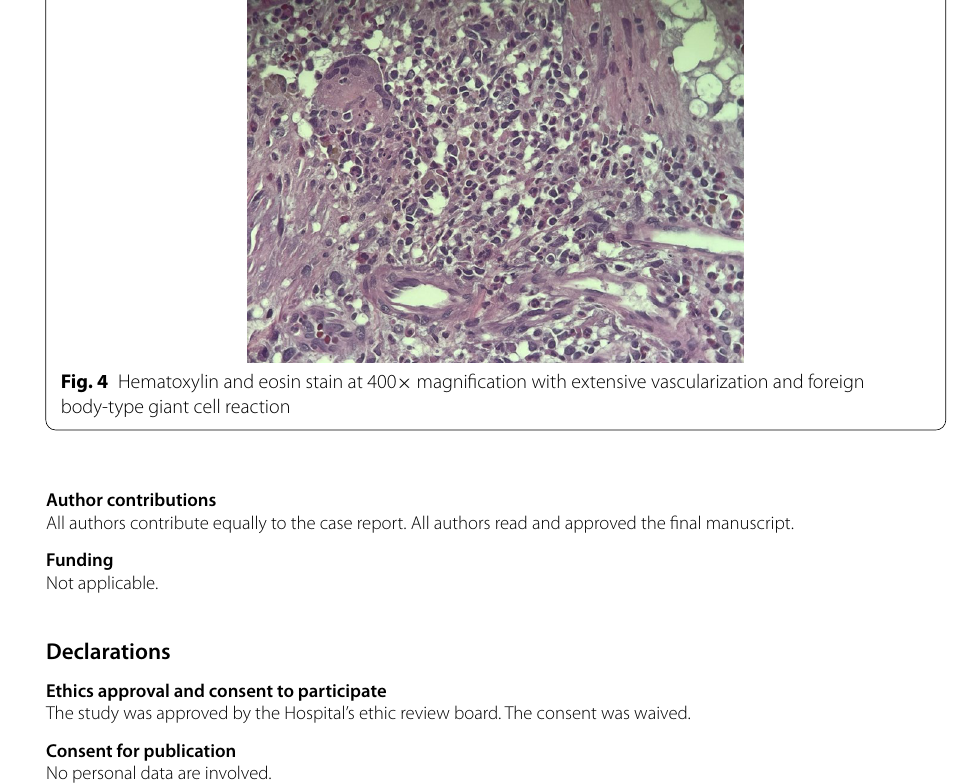
magnification with extensive vascularization and foreign ×